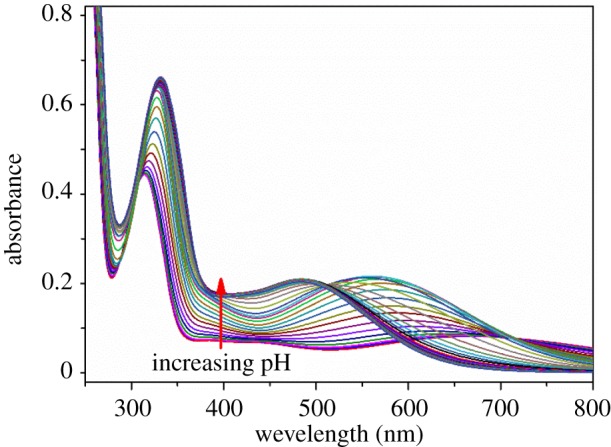
The spectrophotometric titration spectrogram of FeIII–L1H2 complex, condition: [L1H2] = 3 × [FeIII] = 2.0 × 10−4 M, µ = 0.10 M KCl, T = 298.2 K, pH range = 3.9–11.0.